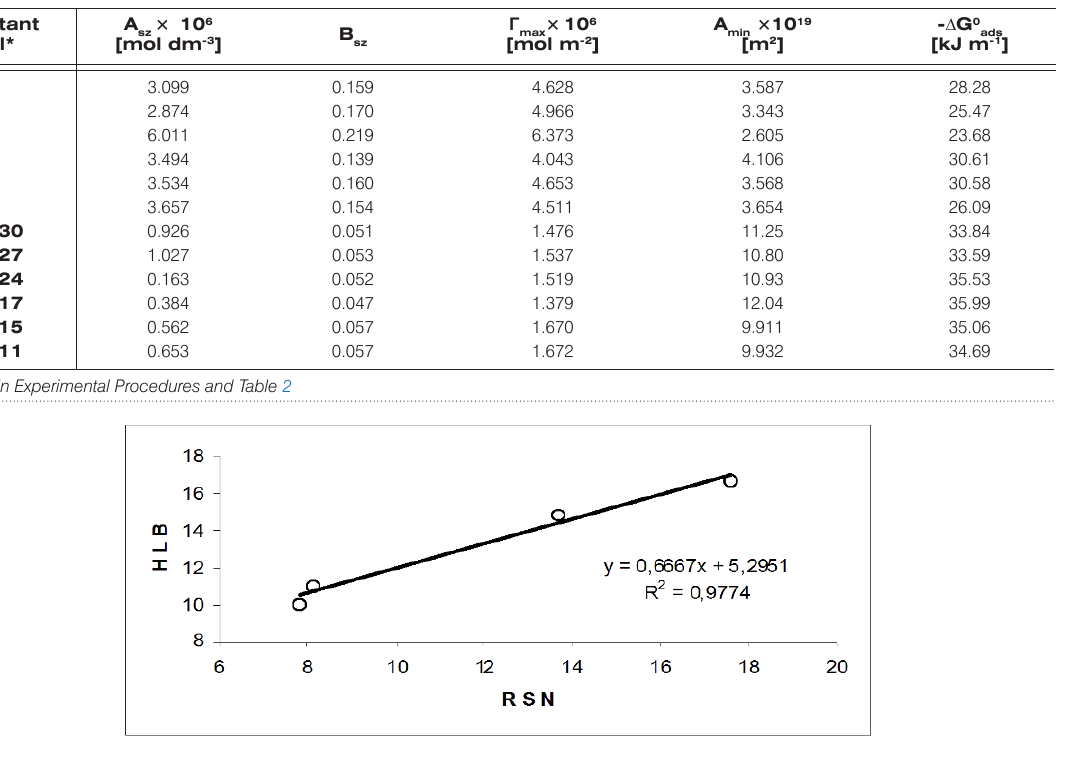
Figure 3. Standard curve of HLB vs. RSN for model systems of Tween 80, 20, 85, 81 surfactants.